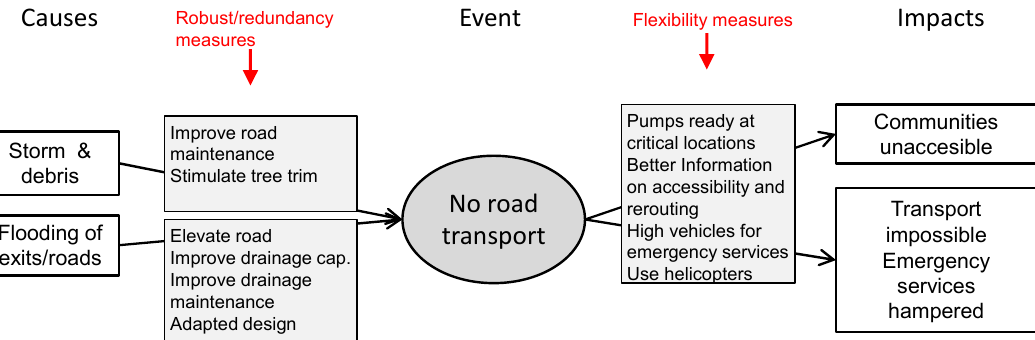
Figure 8. Electricity: causes, impacts, and potential measures which prevent power outages (in the grey blocks on the left side) or mitigate impacts (grey blocks on the right side).